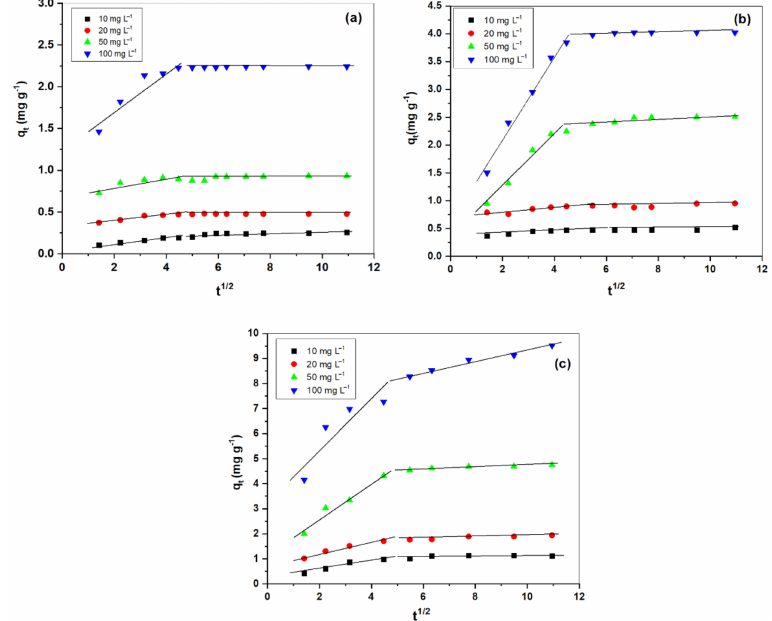
Figure 6. Plots of intraparticle Weber–Morris di ff usion model for Congo red sorption on soil ( a ) IS-65, ( b ) IS-T, ( c )